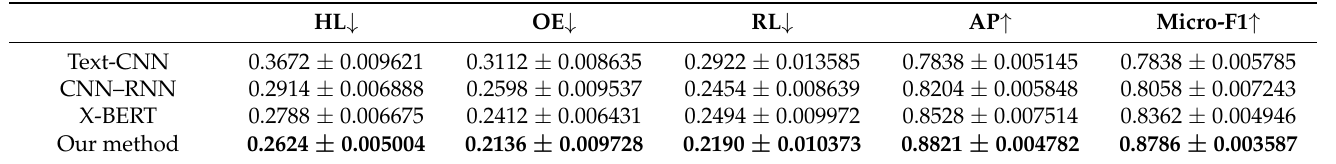
Table 6. Model performance comparison results (MEA ±